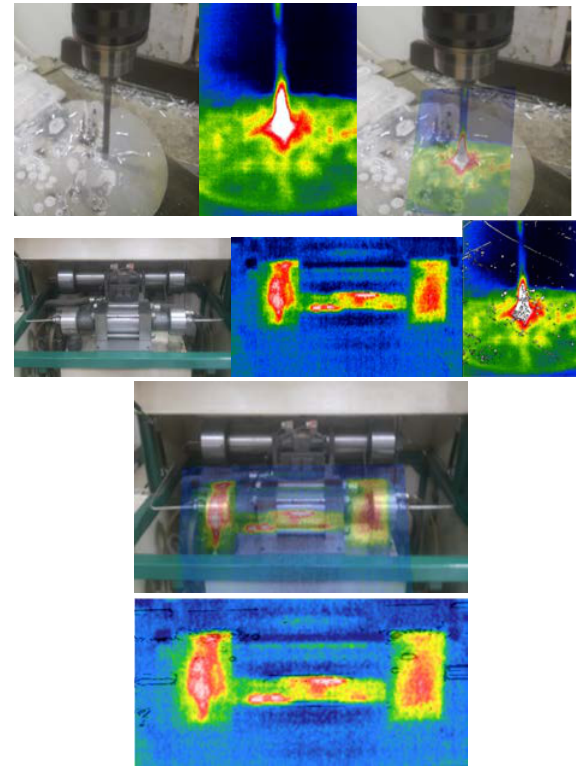
Fig. 3. Algorithm for determining the equidistant curve and the center of mass of objects. Fig. 4 . Example results for search local features on IR